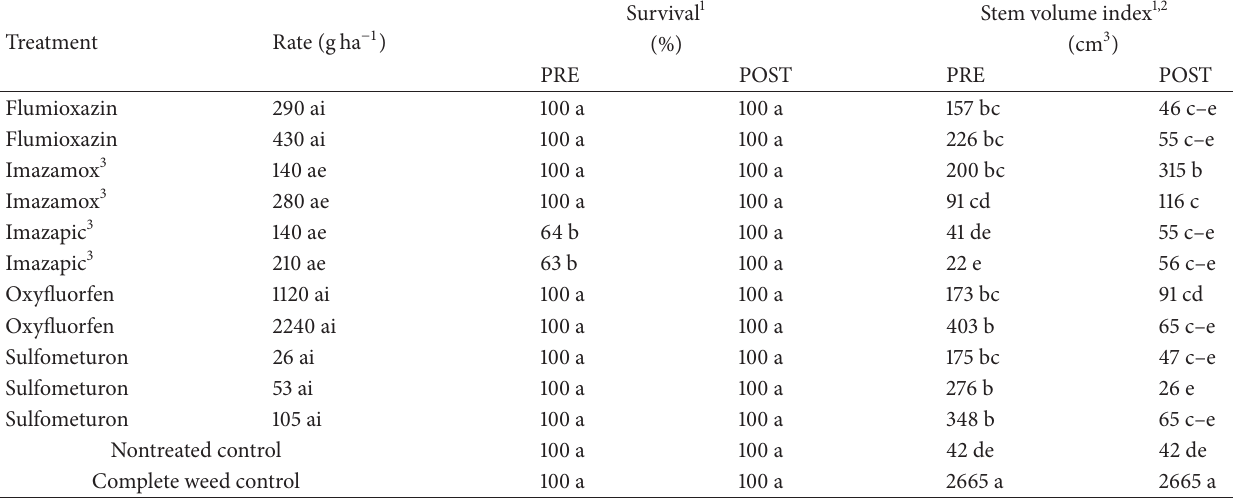
Table 6: Survival and stem volume index of Eucalyptus urograndis trees at the end of the first growing season for preemergence (PRE) or postemergence (POST) applications of various herbicides, in comparison to a nontreated control and complete weed control obtained with repeated foliar sprays of glyphosate herbicide, directed carefully to